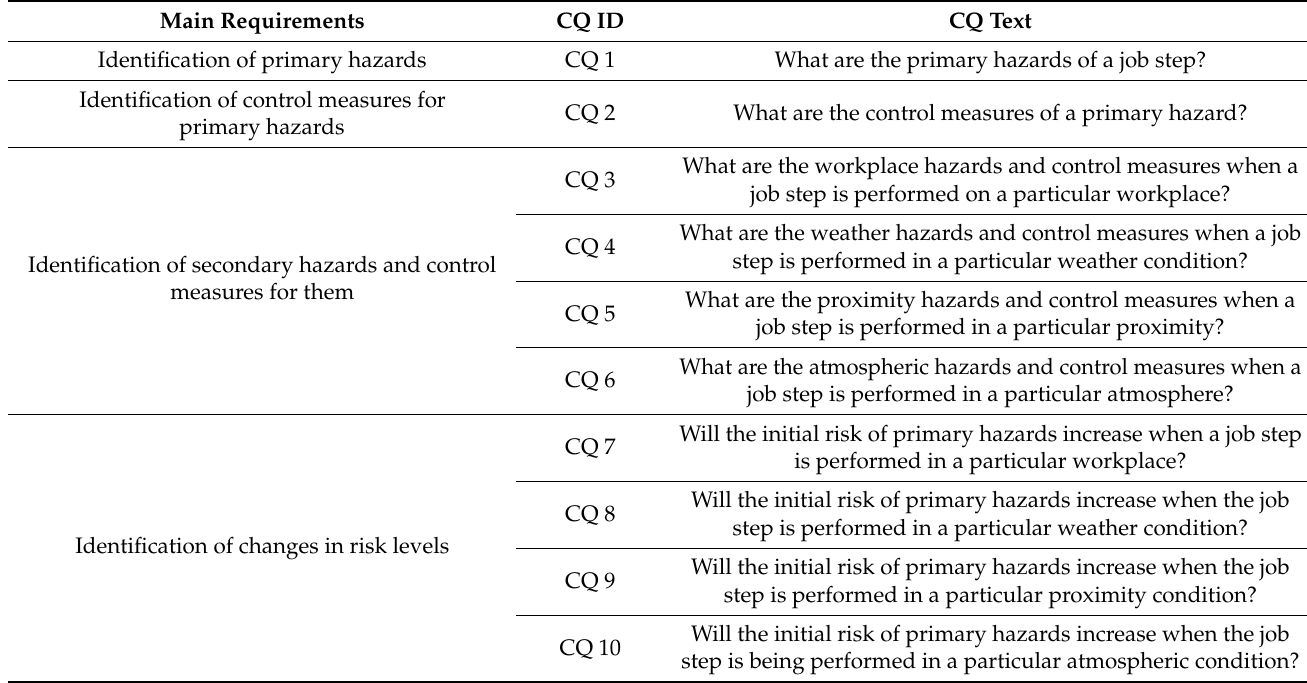
Table 2. Competency